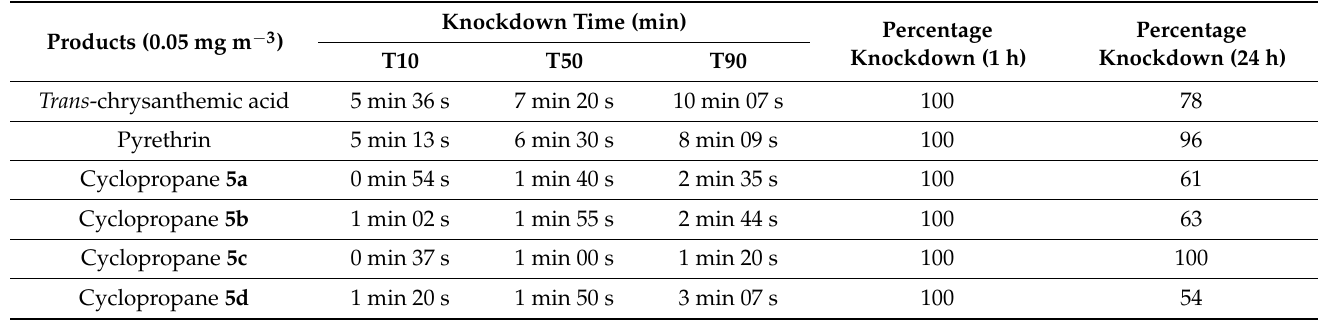
Table 4. The biological efficacy of cyclopropanes 5a–d versus trans-chrysanthemic acid and pyrethrin as a space spray in 22.5 m 3 chambers against Musca domestica .